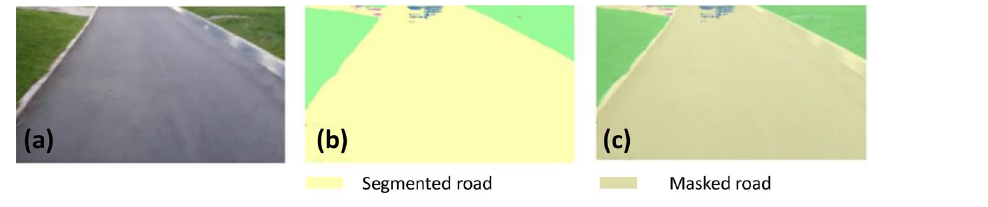
Figure 16. Offline results: road.